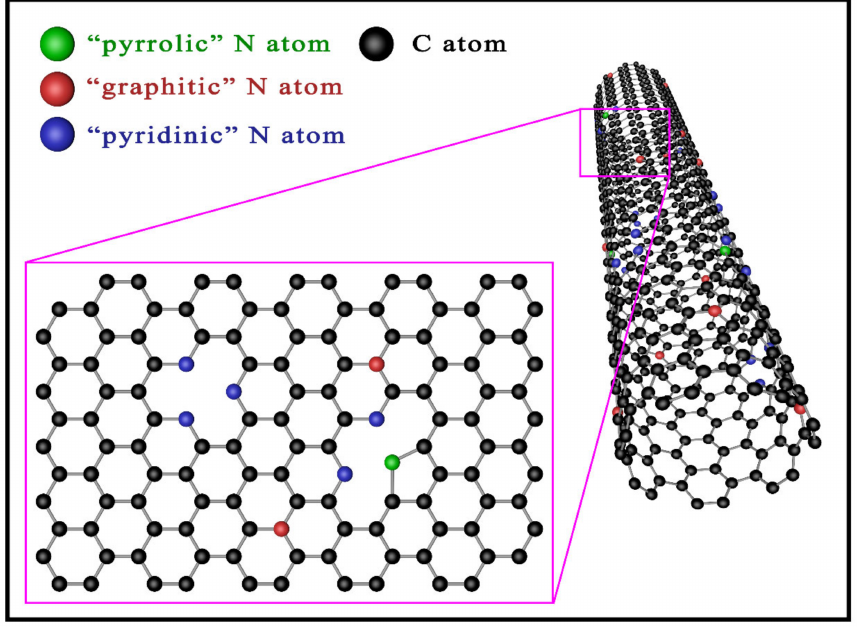
Figure 2. A schematic of carbon nanotubes, graphite matrix, and bonding interactions.